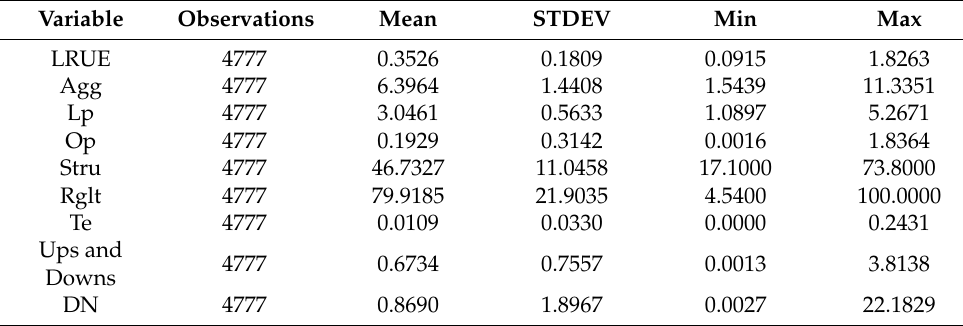
Table 2. Descriptive statistics of